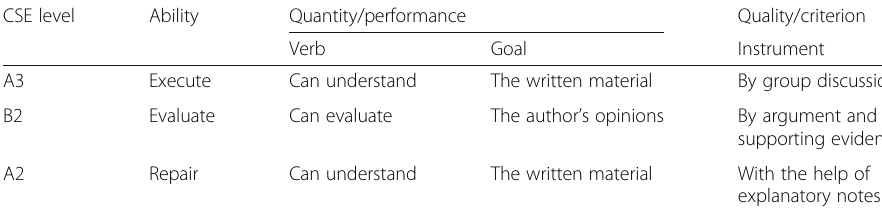
Table 6 Revised parameters of reading descriptor: comprehension strategy CSE